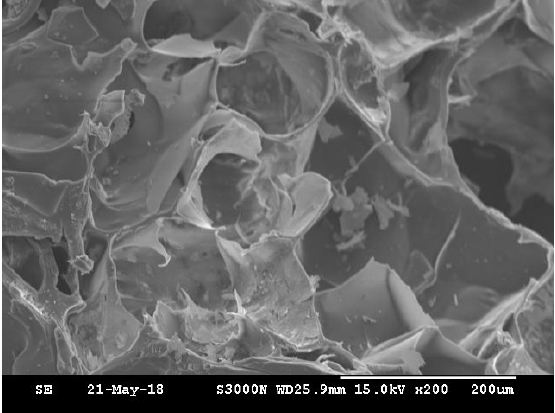
Figure 3. SEM micrographs of the 90G10C containing 20% MBG compositions exposed to LED light for 120 s.